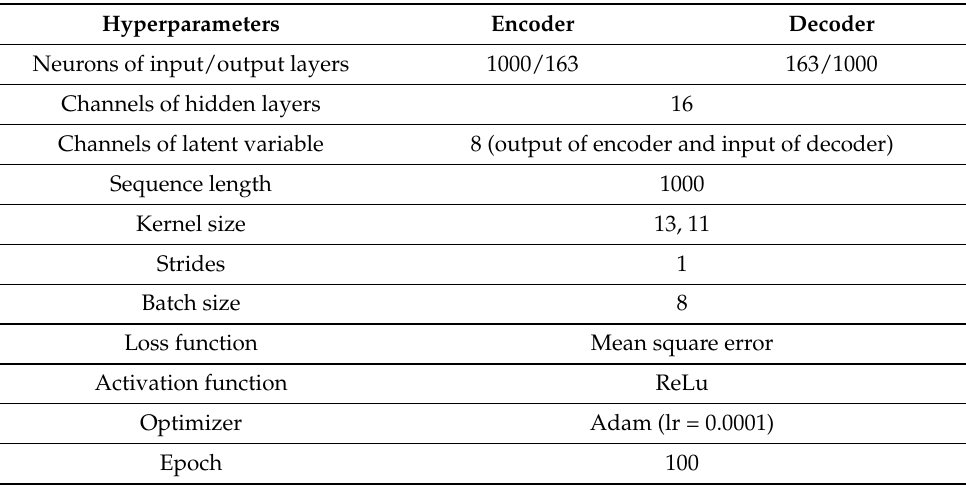
Figure 3. Structure of autoencoder for feature extraction. Table 2. Details of hyperparameters of